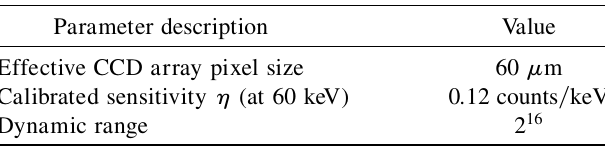
TABLE I. X-ray CCD specifications. Parameter description Value Effective CCD array pixel size 60 + m Calibrated sensitivity , (at 60 keV)